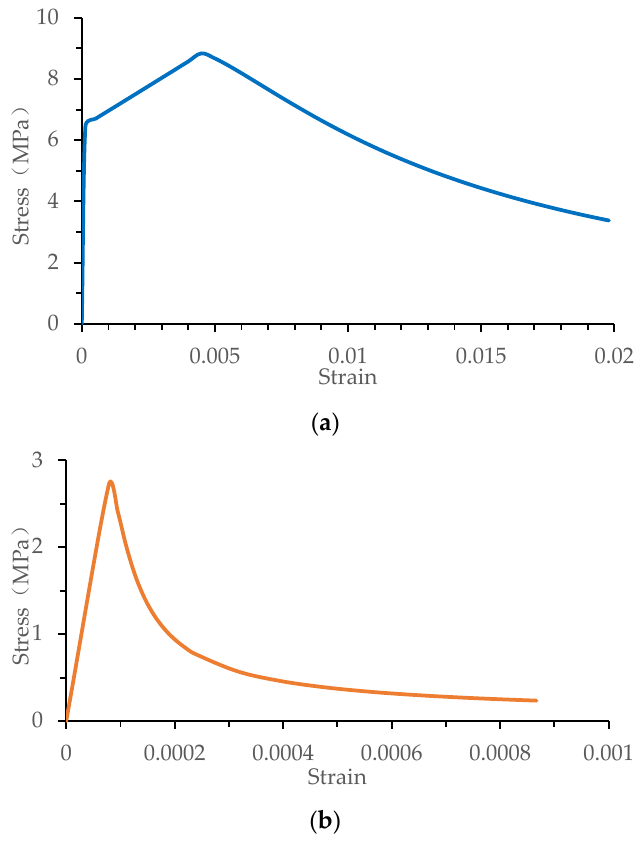
Figure 3. Detailed dimensions of the specimens (unit: mm): ( a ) detailed dimensions of specimen A; ( b ) detailed dimensions of specimen B; ( c ) detailed dimensions of specimen C; ( d ) detailed dimen- sions of specimen D.